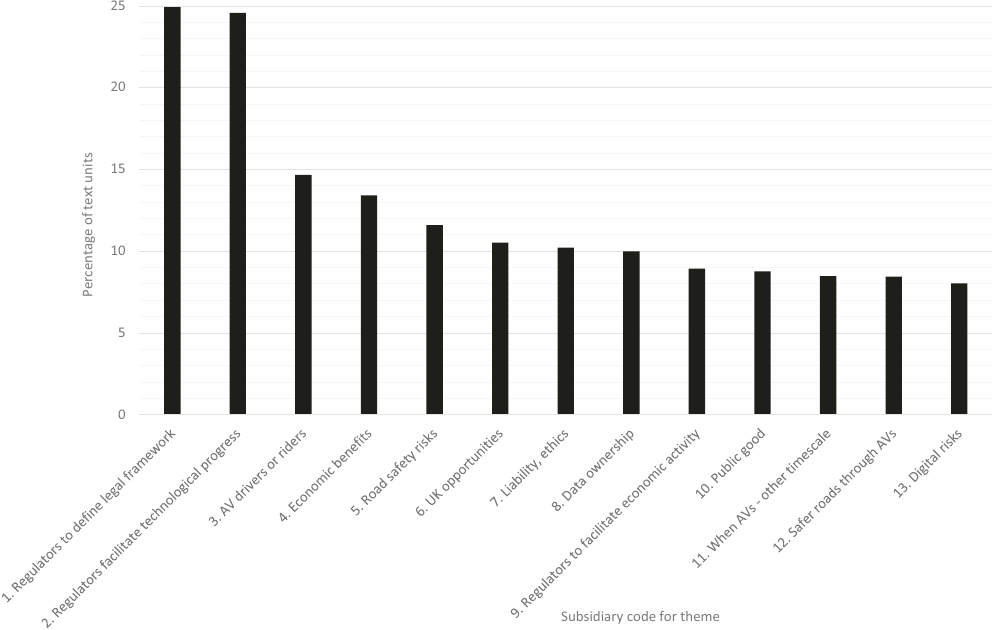
Fig. 1 Most prevalent detailed themes (subsidiary codes) observed for all